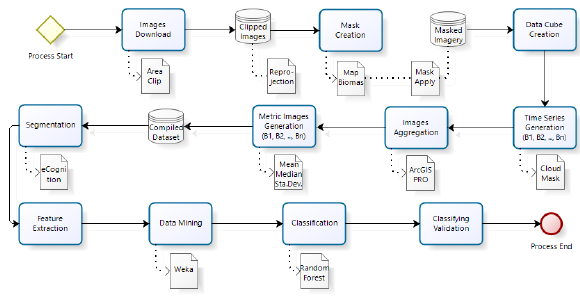
Figure 1. Methodological approach flow chart.